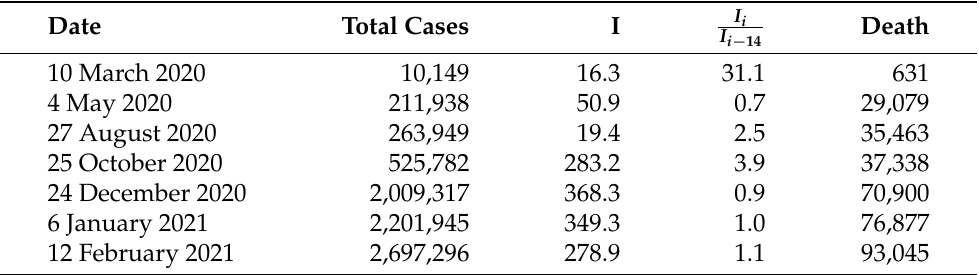
Table 14. Data for Italy: Total cases, Cases per 100,000 inhabitants in the last 14 days, rate of Cases in the last 14 days and the previous 14 days interval, Death related to COVID-19.